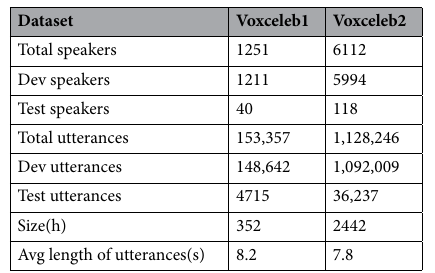
Table 2. Details of Voxceleb1 and Voxceleb2